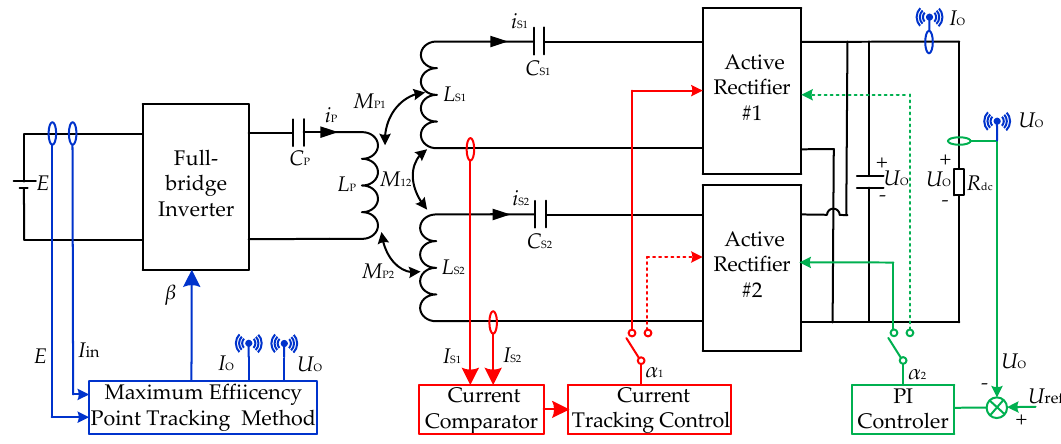
Figure 7. Control scheme of the proposed method.